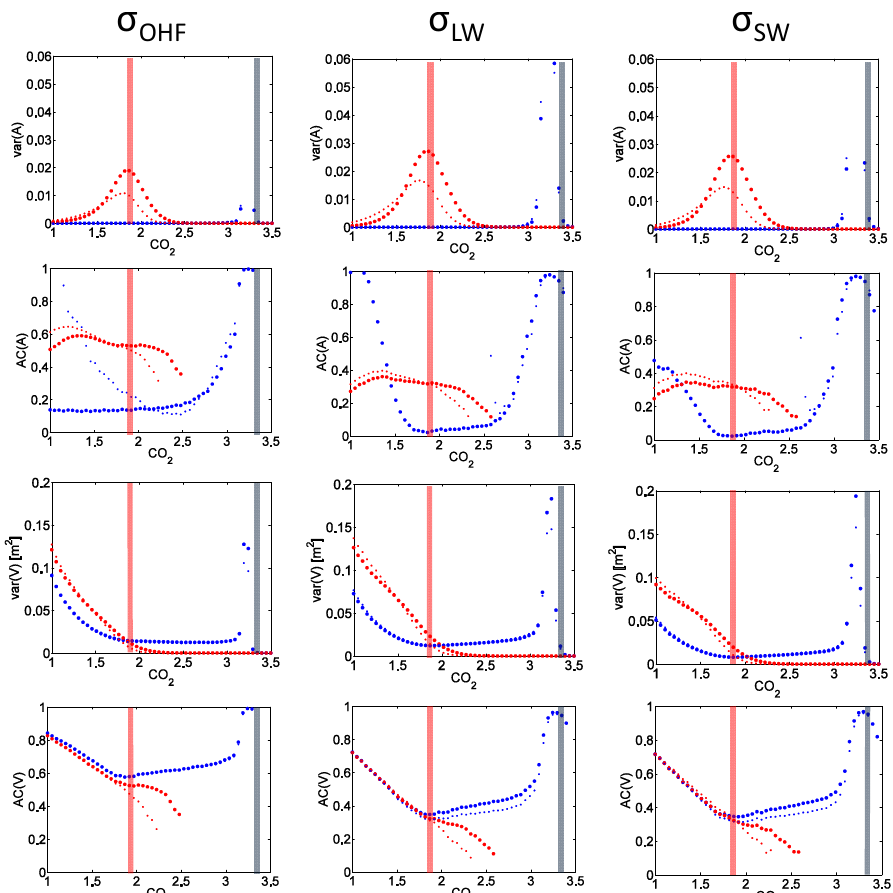
Figure 5. Variance (var) and autocorrelation (AC) of ice-area fraction A and ice volume V as a function of CO 2 in the model E07 with large red noise. In each column, the noise term has been introduced to one of three different terms, namely the ocean heat flux (OHF), long-wave radiative balance (LW), and short-wave radiative balance (SW). Winter sea ice is shown in blue and summer sea ice in red (seasons as in Fig. 1). The vertical shaded lines indicate the values of CO 2 where the annual minimum (red lines) and maximum (blue lines) ice volume reaches